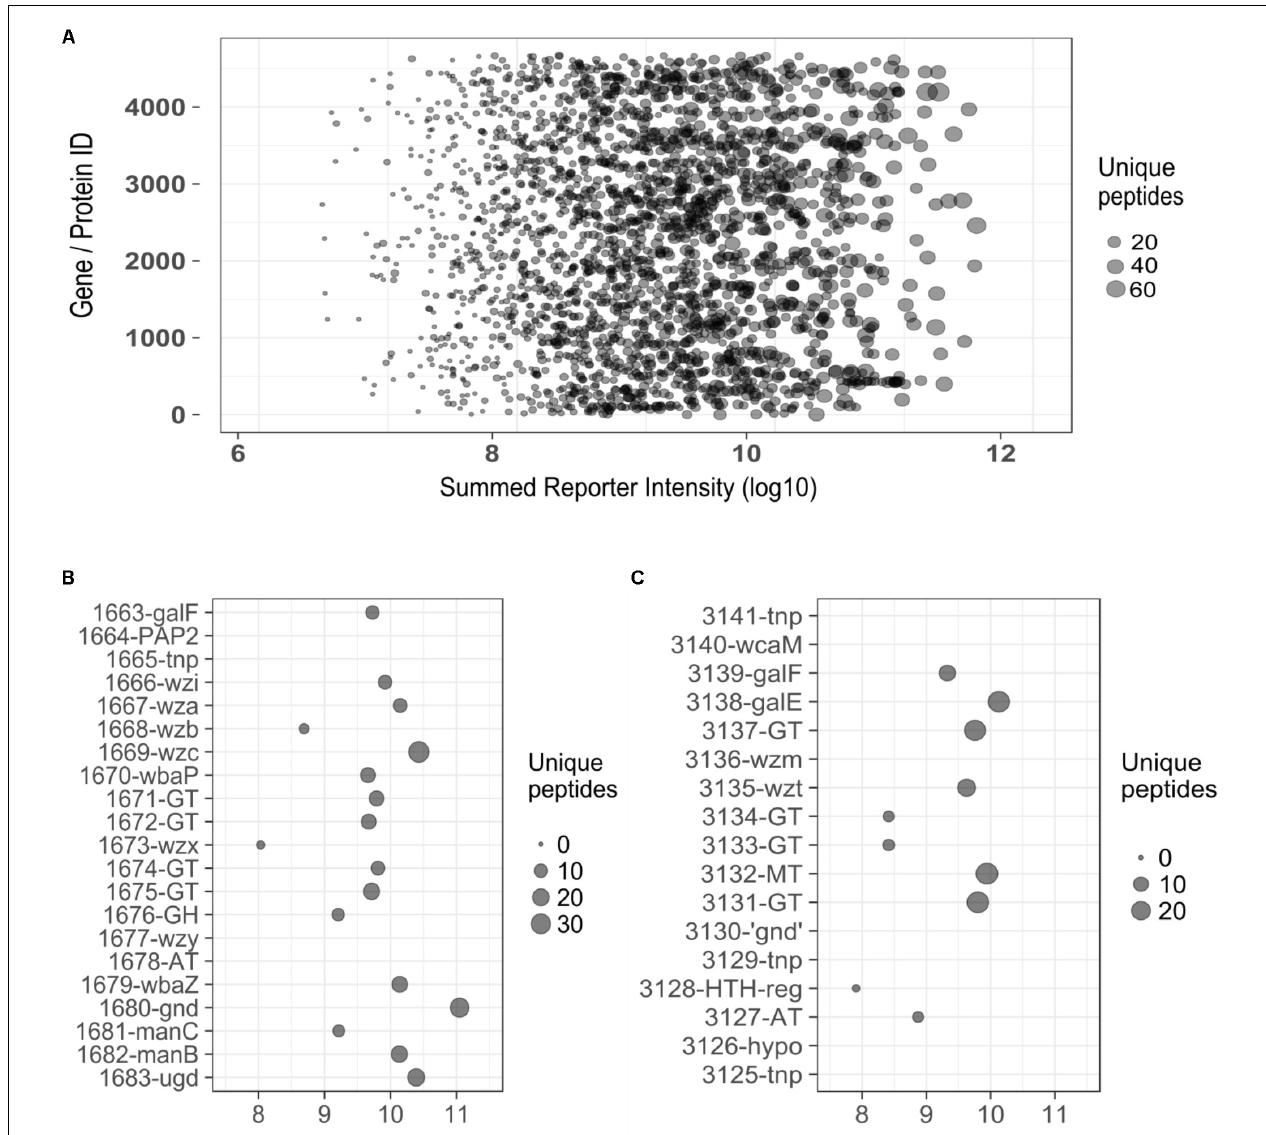
FIGURE 5 | (A) Plot displaying the range of reporter intensities for all 2451 proteins identified in E. coli 26561. (B) Expanded section of plot (A) detailing identifications for proteins in the capsule region ( y -axis). (C) Expanded section of plot (A) detailing identifications for proteins in the ‘O-antigen’ region ( y -axis). ‘Summed Reporter Intensity’ ( x -axis in all figures) represents the total signal detected from 10 TMT-labeled samples. tnp, transposon; GT, glycosyl-transferase; GH, glycosyl-hydrolase; AT, acyl –transferase; MT, methyl-transferase; ‘gnd,’ truncated